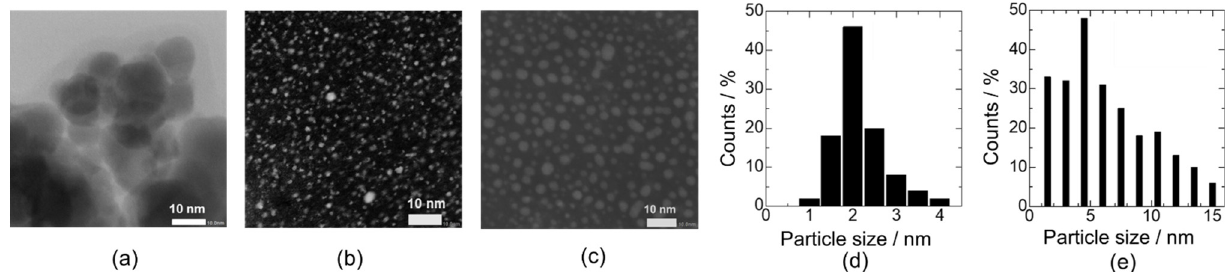
Figure 3. TEM images of ( a ) SnO 2 nanoparticles, and Pd nanoparticles after the drying process using the ( b ) SI and ( c ) CP methods without SnO 2 nanoparticles. Particle size distributions of the Pd nanoparticles using the ( d ) SI and ( e ) CP methods.